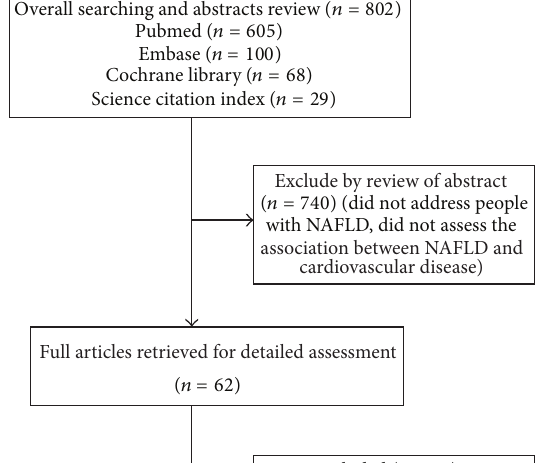
interval 1.68 to 2.10; 𝑃 < 0.001 ) and no major asymmetrical appearance in the funnel